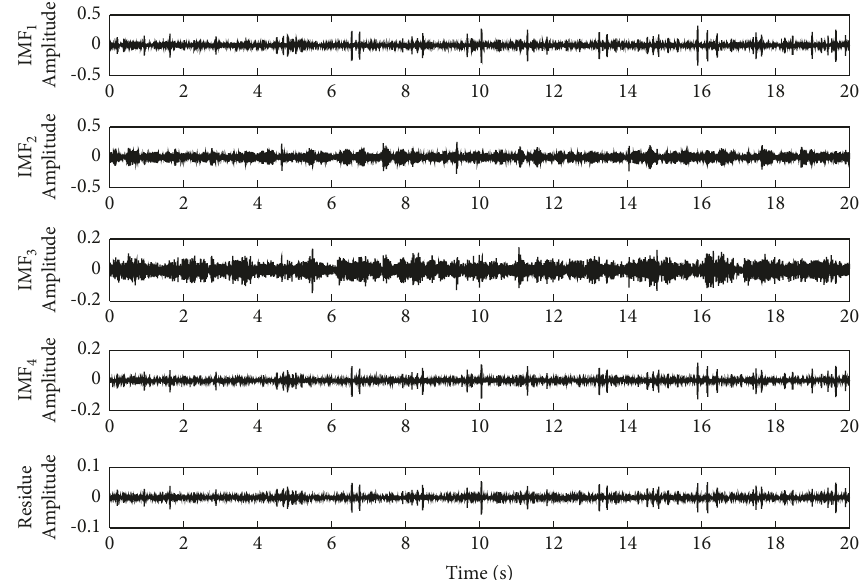
Figure 9: The decomposition results generated by BMD of a vibration signal from class